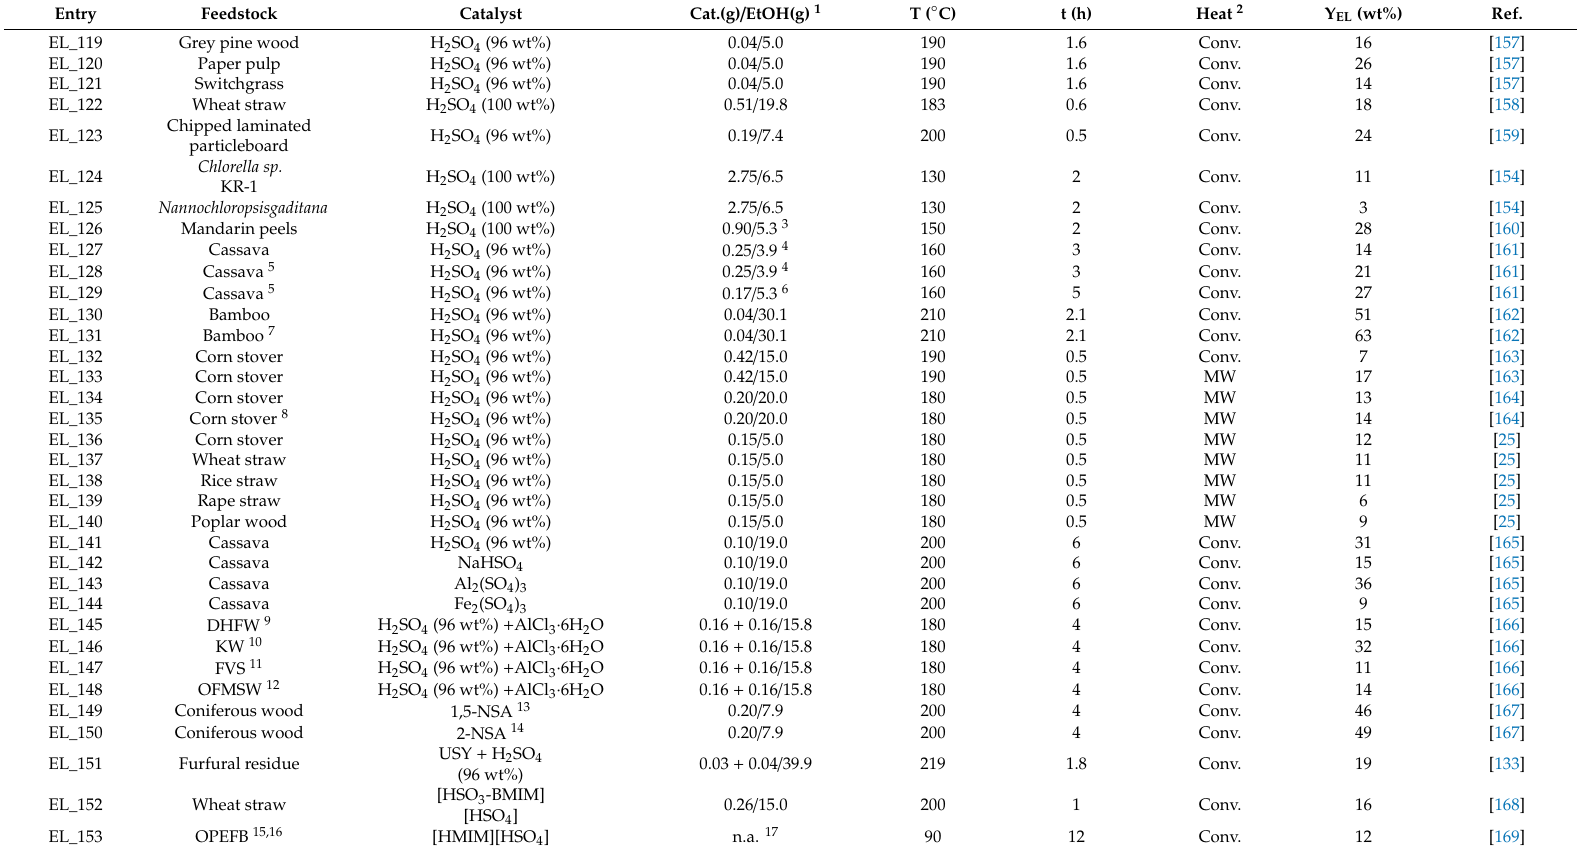
Table 16. Catalysts for the EL production from real